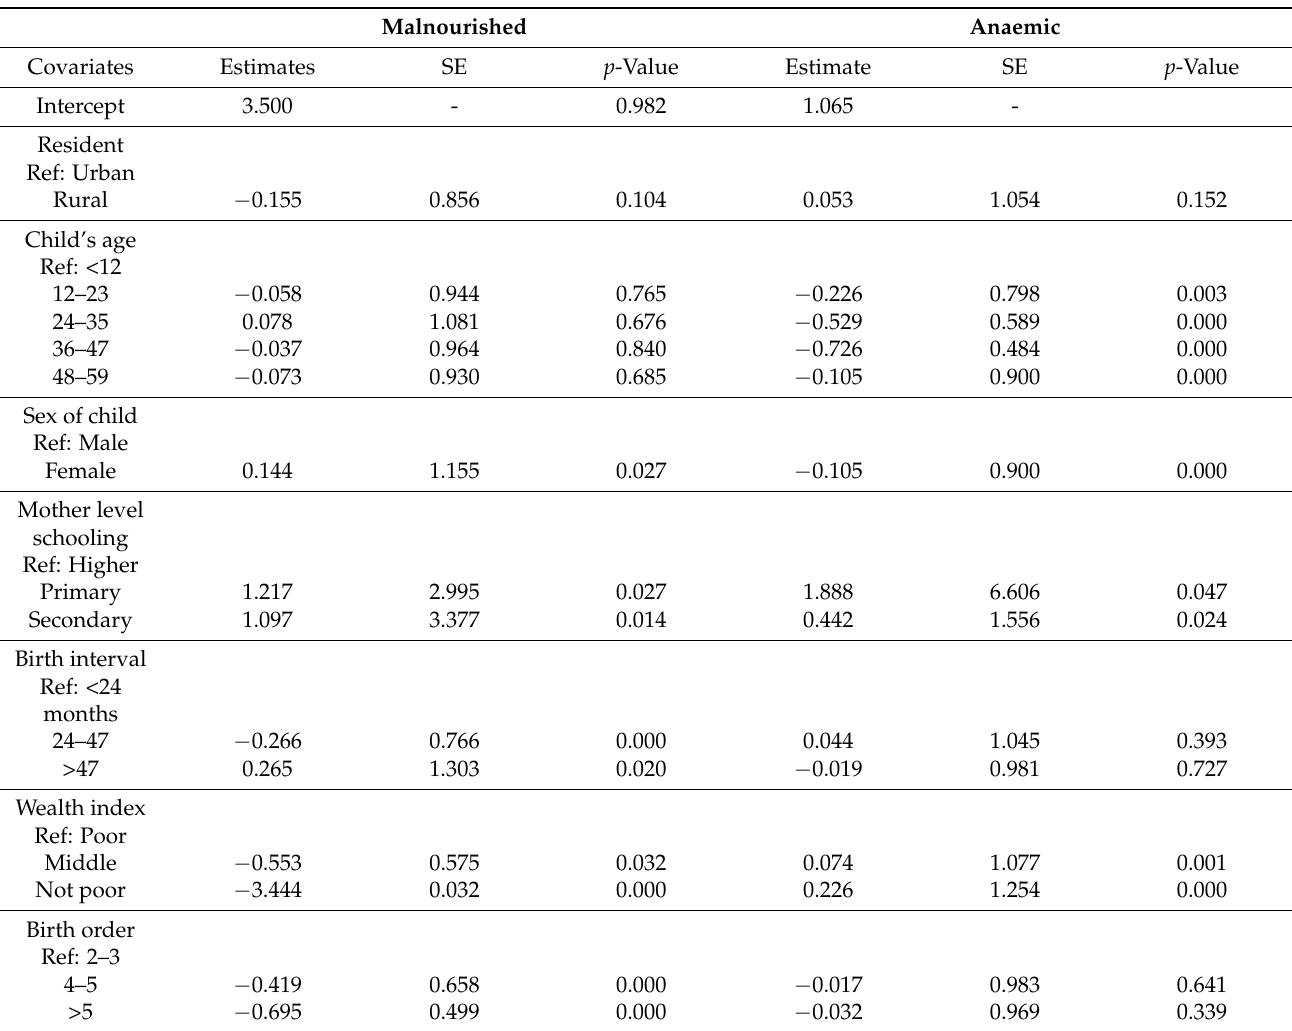
Table 5. Parameter estimates of the fixed effects for the bivariate copula regression model of malnu- trition and anaemia. Malnourished